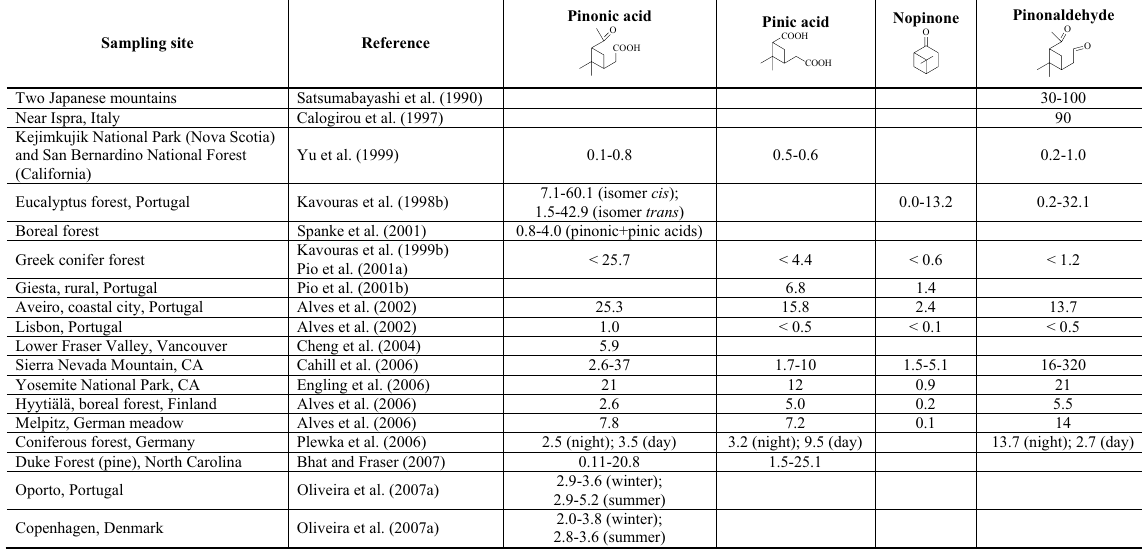
Concentrations (ng m -3 ) of some terpene photo-oxidation products detected in aerosols from field experiments.